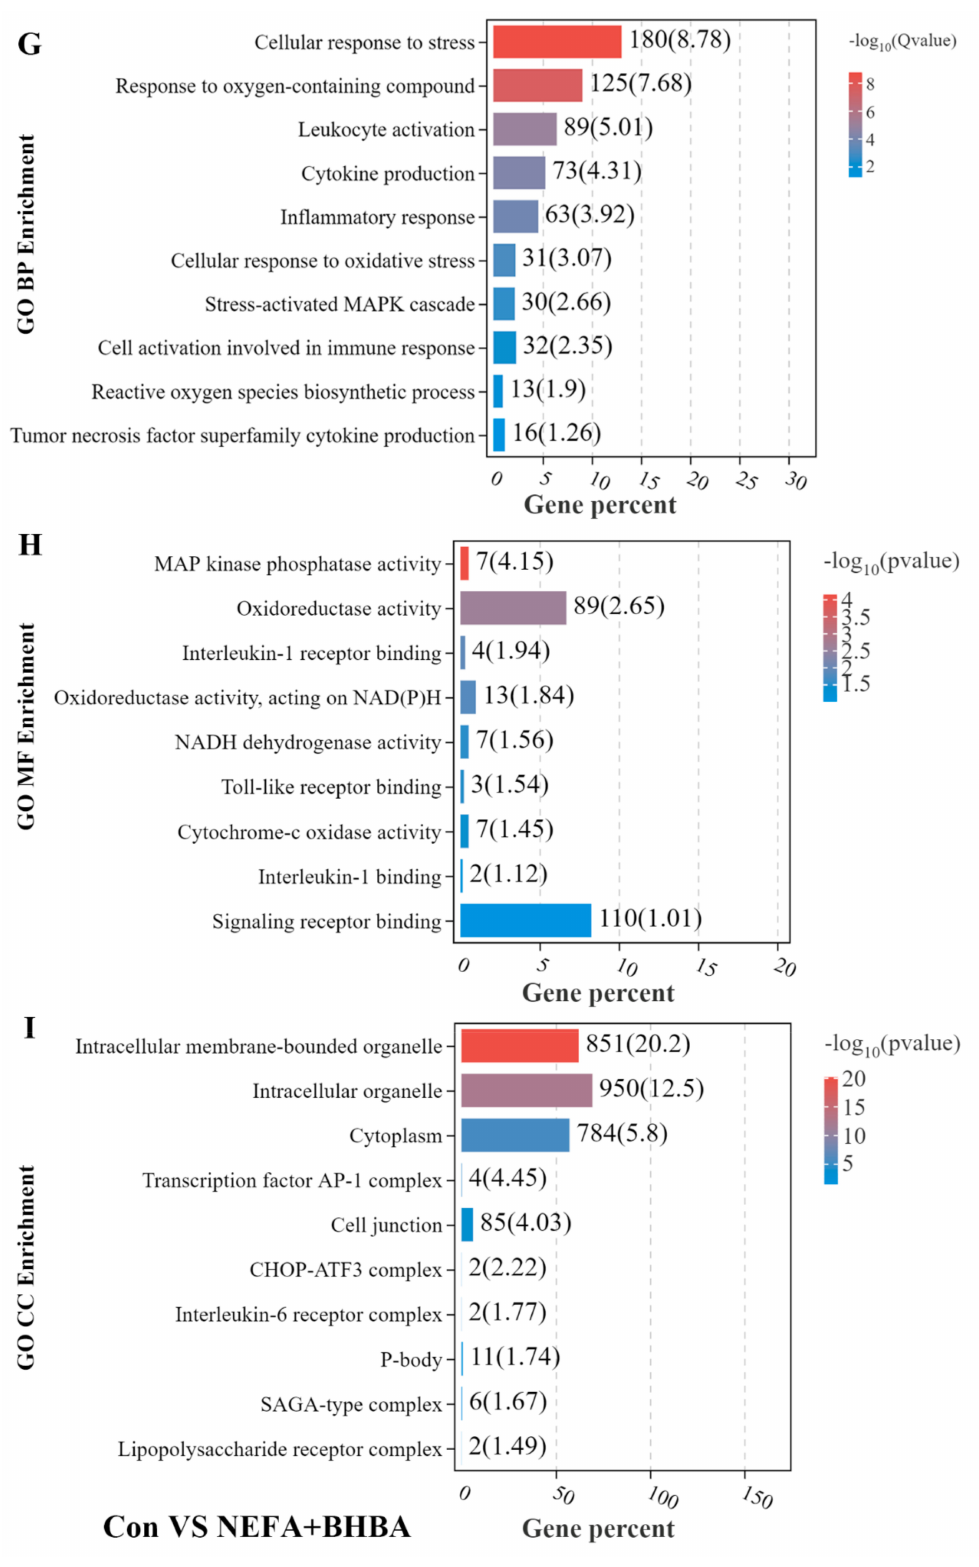
Figure 2. GO functional enrichment analysis of DEGs. ( A – C ) GO enrichment analysis of DEGs between control and NEFA treatment group. ( D − F ) GO enrichment analysis of DEGs between control and BHBA treatment group. ( G – I ) GO enrichment analysis of DEGs between control and the combinative treatment (NEFA and BHBA) group in BMECs. BP, biological processes; MF, molecular function; CC, cellular